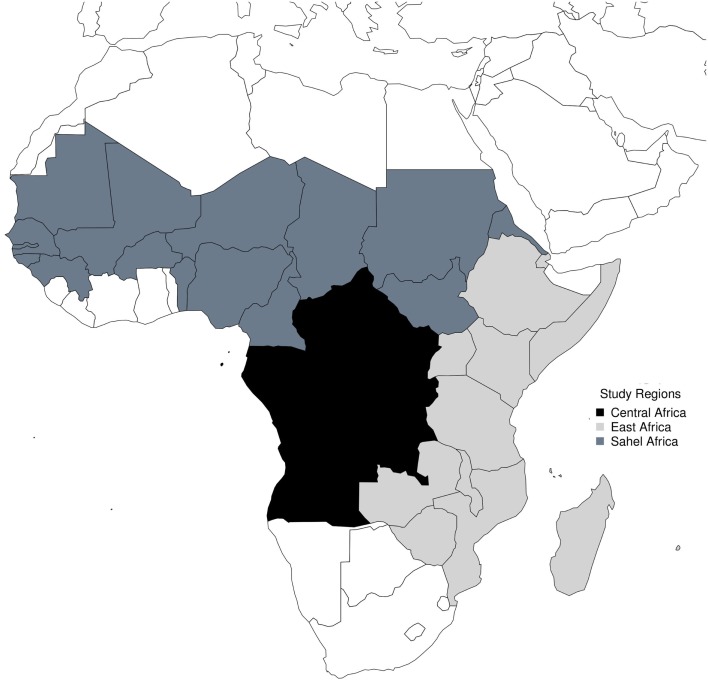
Map of study sites.